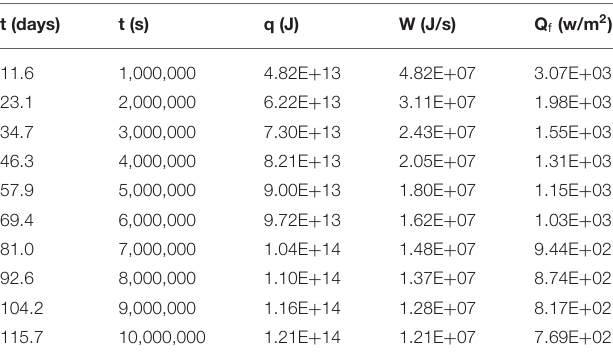
TABLE 3 | Heat flux (Q f ) values for cooling of a 50m radius silicic lava dome over ∼ 116 days. t